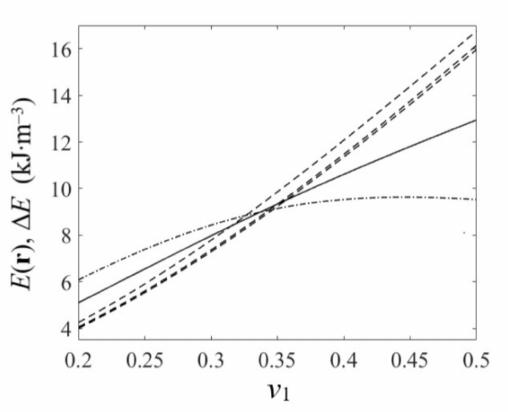
Figure 6. Bulk density of strain energy E ( r ) in H 2 O inclusions (dashed lines) and in the por-Si matrix (dash-dotted line), and average density of strain energy ∆ E (solid line) vs. volumetric content v 1 of